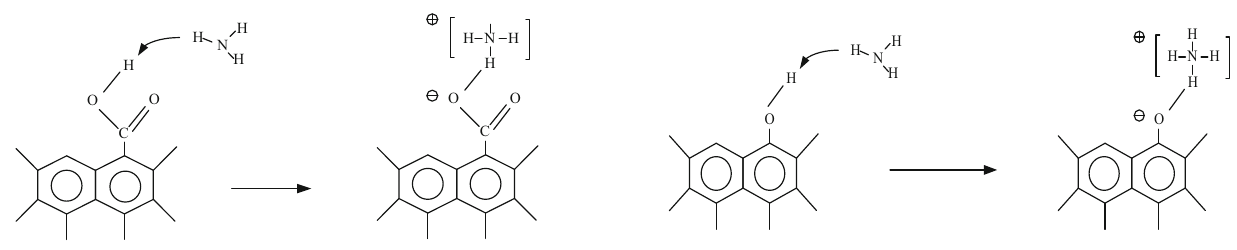
Fig. 8 Reaction step for the formation of surface [NH 4 ] ? complexes